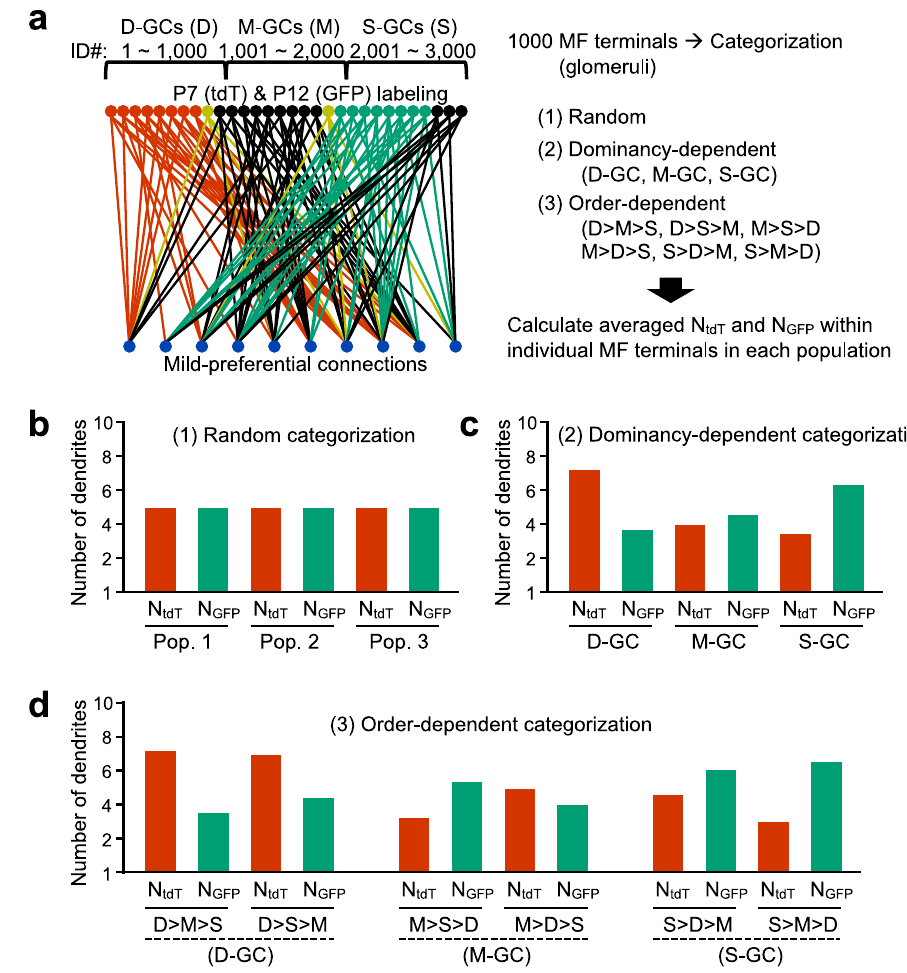
Fig. 6 Interpretation of synaptic connections with speci fi c MF terminals by mild preferential model. a Diagram of mild preferential connection model with mimicked labeling of GCs by P7&P12 injection (left). Red, green, and yellow GCs represent GCs expressing tdT, GFP, and both, respectively. GCs are divided into D-GCs, M-GCs, and S-GCs, based on ID numbers. MFs are categorized into populations based on one of three criteria (right), which are made according to groups of GCs connecting. Numbers of tdT (N tdT )- and GFP (N GFP )-positive GC dendrites within individual MF terminals are then averaged in each population. b – d Averaged N tdT and N GFP in different populations of MF terminals, when MF terminals were categorized by random categorization ( b ), dominancy-dependent categorization ( c ), or order-dependent categorization ( d